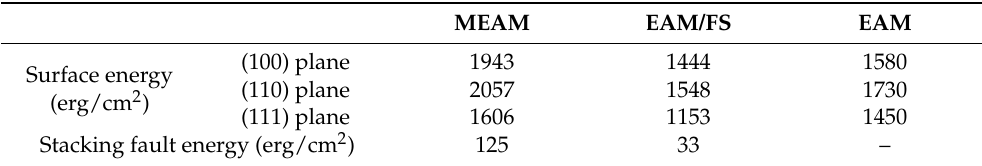
Table 1. The computed properties of single-crystal Ni for the different styles of potentials. MEAM EAM/FS EAM (100) plane 1943 1444 1580 Surface energy (110) plane 2057 1548 1730 (erg/cm 2 ) (111) plane 1606 1153 1450 Stacking fault energy (erg/cm 2 ) 125